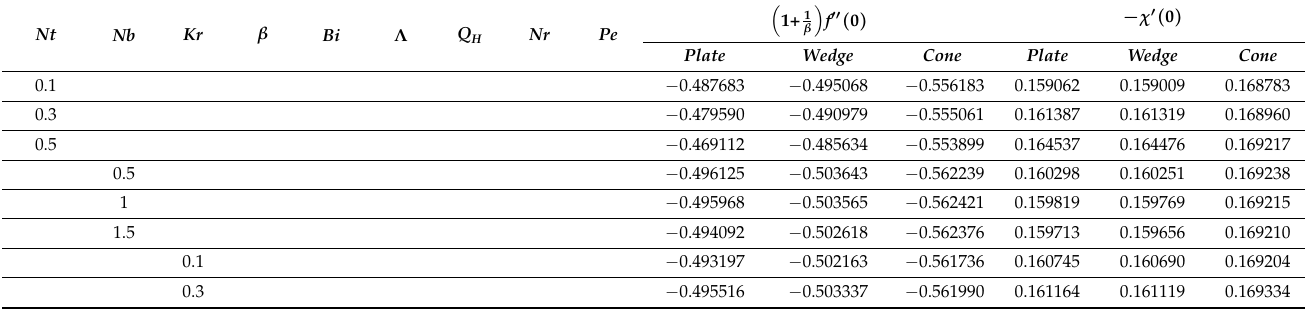
(cid:16) (cid:17) 1 + 1 and − χ (cid:48) ( 0 ) for flow over a cone, wedge, and β